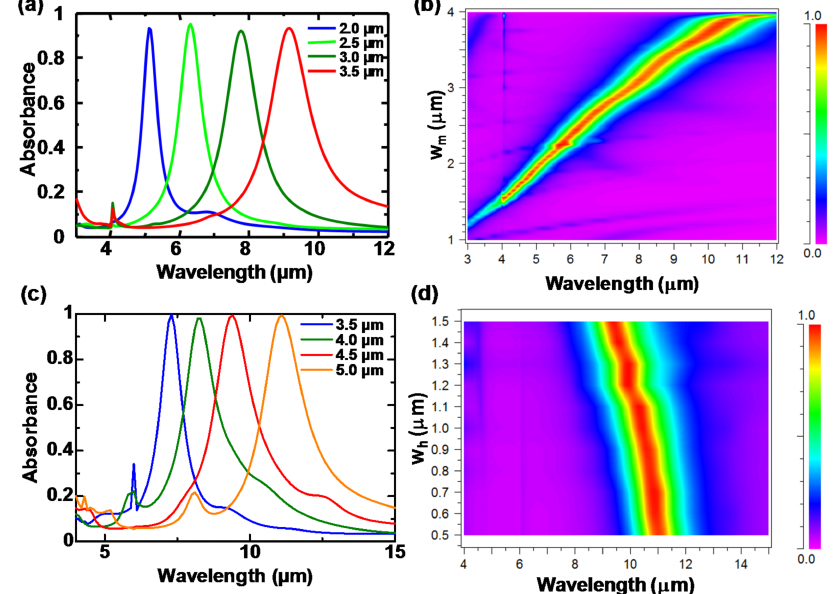
Figure 11. Calculated absorbance spectra of MR-PMAs with cylindrical posts. ( a ) Spectra for various w m and ( b ) as a function of wavelength and w m . Calculated absorbance of MR-PMAs with tubular posts; ( c ) Spectra for various w m and ( d ) as a function of wavelength and w h . The color map defines the absorbance